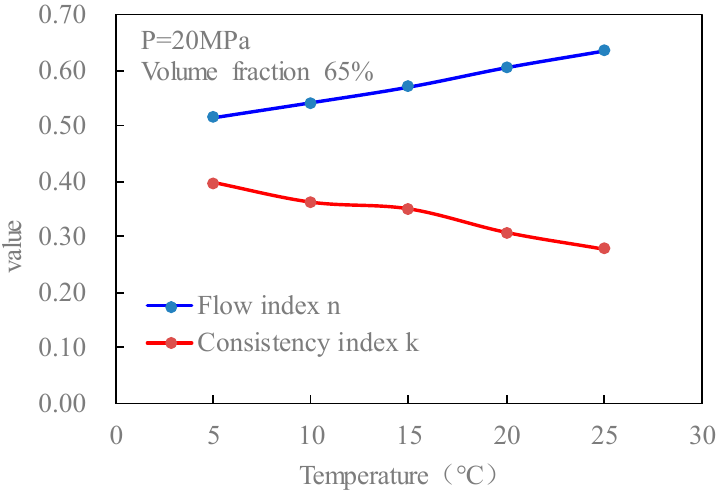
Figure 15. Variation curves of flow index n and consistency index k with temperature (unfoamed).